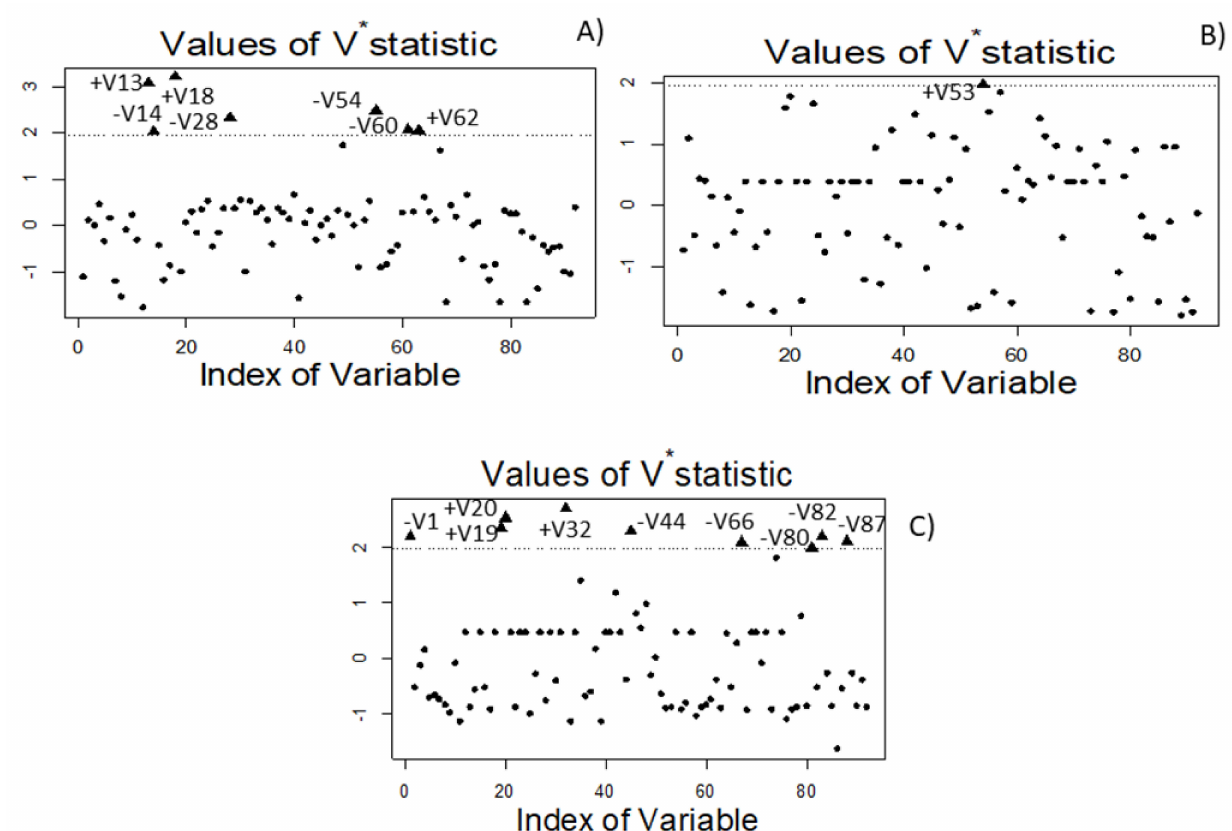
Figure 9. Biomarkers identified using the Walach et al. [22] test. Plots correspond to, ( A ) spoiled butyric samples (F282 and F283) vs normal samples (F284, F285, F286, and F309) from industry A; ( B ) sulfidic (F508) vs normal samples (F502 and F592) from industry B; and ( C ) putrid (F562) vs normal samples (F502 and F592) from industry B. See text for correspondence between VOC indexes and their names. V*statistic stand for the standardized Walach et al.